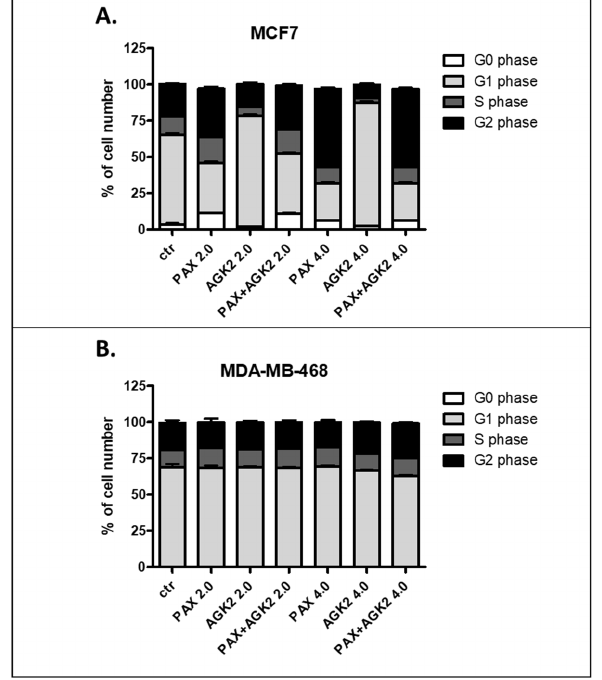
Figure 17. Effect of AGK2 and paclitaxel (PAX) alone or AGK2 combined with PAX on cell cycle progression in the ( A ) MCF7 luminal and ( B ) MDA-MB-468 TNBC cells. BC cells were exposed to individual or concomitant PAX and AGK2 treatment for 48 h using selected ratios of the IC 50 determined in the MTT assay (2.0 = IC 50 + IC 50 , 4.0 = 2IC 50 + 2IC 50 ), stained with propidium iodide (PI) and analyzed by means of FACS. The data are presented as the means ± standard deviation (±SD).